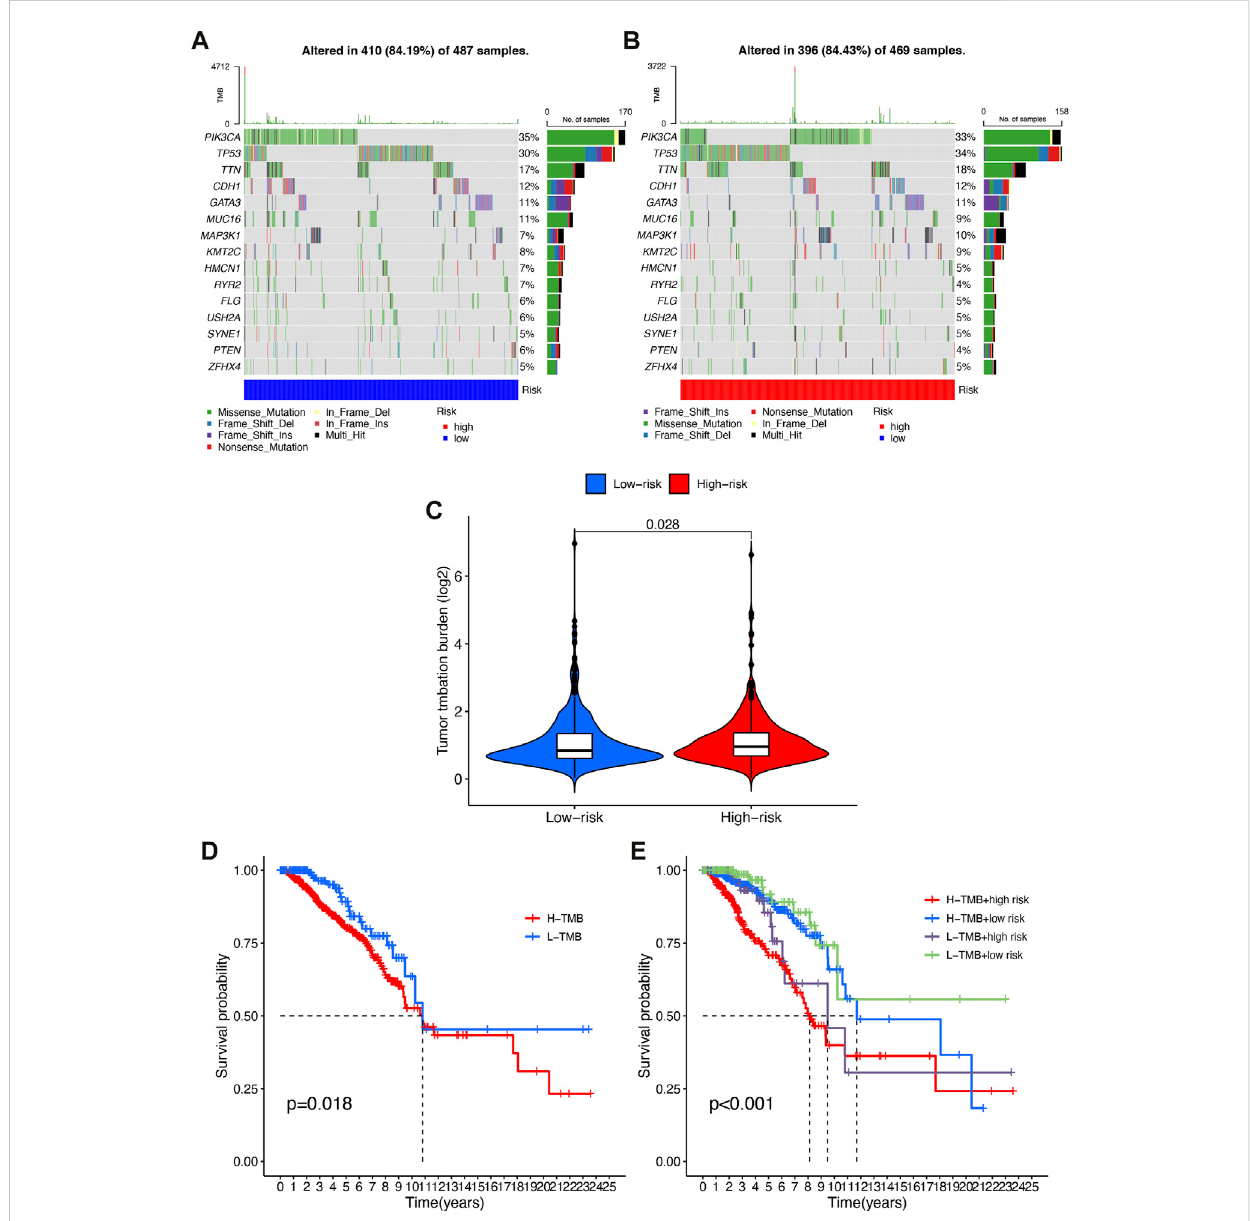
FIGURE 8 CorrelationofriskscorewithTMB. (A) Oncoprintofthesomaticmutationallandscapeofthelow-riskgroup. (B) Oncoprintofthesomaticmutational landscape of the high-risk group. (C) TMB differences between patients in low/high risk score subgroups. (D) Kaplan-Meier curves of high and low TMBgroups. (E) Kaplan-Meier Q19 curves of patients strati fi ed by TMB and risk